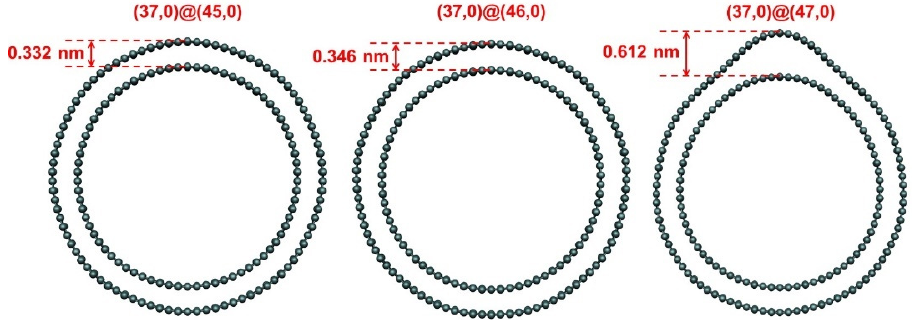
Figure 9. DFT-D2 relaxed cross-sections for different helicity combinations of zigzag DWCNTs. Intershell spacings are marked in nm. Note that the structure on the right is asymmetric with buckling deformation, hence forming a channel-like cavity (the intershell spacing in the DWCNT part opposed to the bulge is ~0.344 nm).